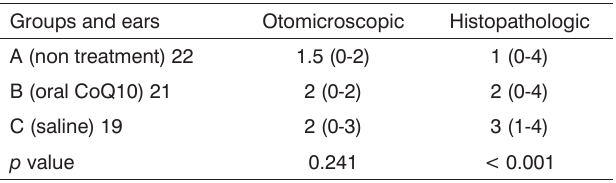
Table 2. Comparison of median values in otomicroscopic and histopathologic examinations.